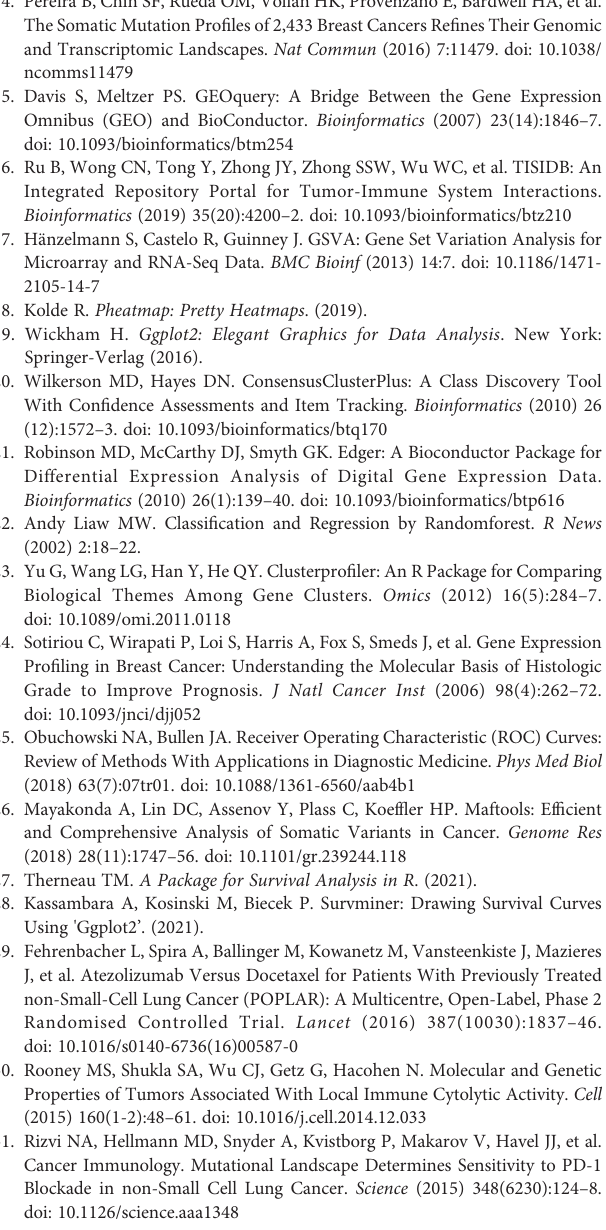
Supplementary Figure 4 | Screening of MRDEGs. (A) The relationships between the predictive error rate and the number of trees with random forest. The three lines in different colors represent three distinct ICI genotypes. (B) The top 30 MRDEGs according to mean decreasing accuracy and decreasing Gini. (C) The landscape of these top 398 MRDEGs. The rows represent MRDEGs and the columns represent BRCA samples. (D) The bubble plot of GO functional annotations with MRDEGs. Supplementary File 1 | The immune cells gene set. Supplementary File 2 | Relative Fractions of tumor-in fi ltrating immune cells of 112 normal tissues and 968 tumor tissues with TCGA-BRCA